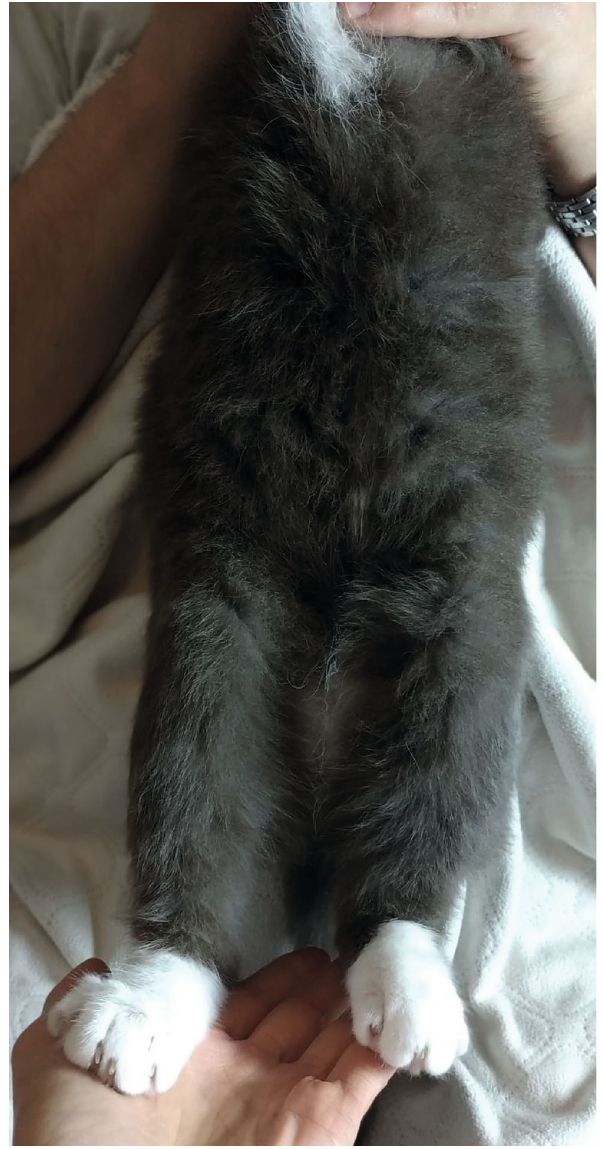
Figure 4: Complete hair regrowth and resolution of skin lesions on ventral abdomen and hind limbs 12 months after initiating